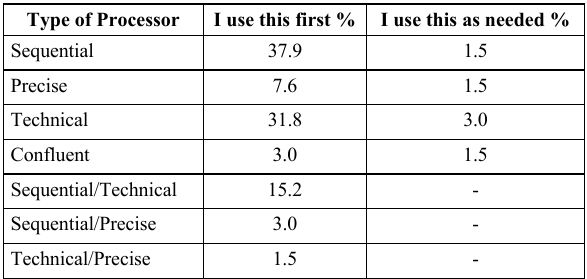
TABLE I. R ESPONDENTS : S TRUCTURE OF THE G